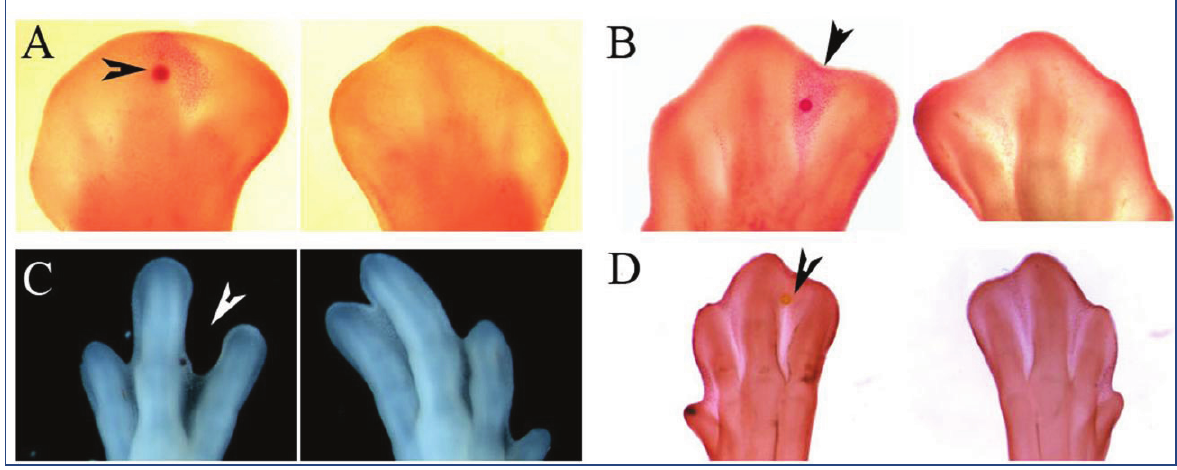
Figure 3. Retinoic acid (RA) participates in interdigital cell death. ( A ) A 50 mM RA-soaked bead was placed in the undifferentiated zone in the tip of the digit at stage 27HH and induced cell death (arrowhead) after 24 h; cell death was not observed in the contralateral limb. ( B ) A 50 mM RA-soaked bead was placed in the interdigital tissue at stage 28HH and induced cell death (arrowhead) after 24 h. Note a wider region of cell death in comparison with the contralateral limb. ( C ) A 50 mM RA-soaked bead was placed in the interdigital zone at stage 29HH and after 48 h accelerated the regression of the interdigital tissue (arrowhead) compared with the contralateral limb. ( D ) A 20 mM AGN193109 (RARs antagonist)-soaked bead was placed in the interdigital region at stage 30HH and after 24 h of treatment interdigital cell death (arrowhead) was inhibited. Neutral red staining is shown in A, B and